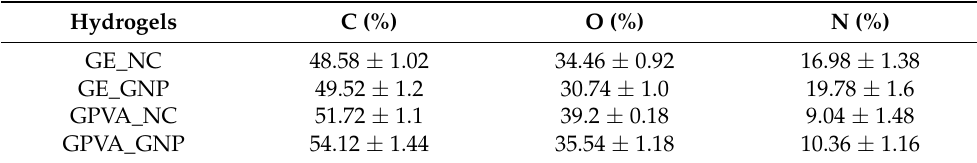
Table 2. Distribution of elemental composition of carbon (C), oxygen (O), and nitrogen (N) in GPVA hydrogels.